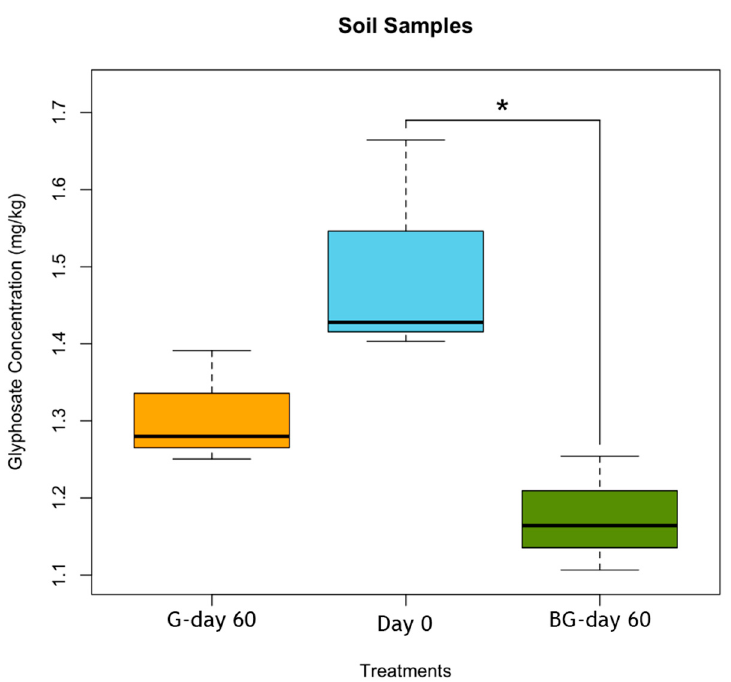
Figure 6. Boxplot of glyphosate concentration for different treatments. Glyphosate was determined by the standard addition method at days 0 and 60 for BG and G treatments. BG: bacteria-glyphosate, G: Glyphosate (roundup 747). Statistical analysis was performed using ANOVA (one-way) Results are shown as the mean ± SEM, and datasets were analyzed by the Tukey-Kramer test, with significance level: 0.05 (*).